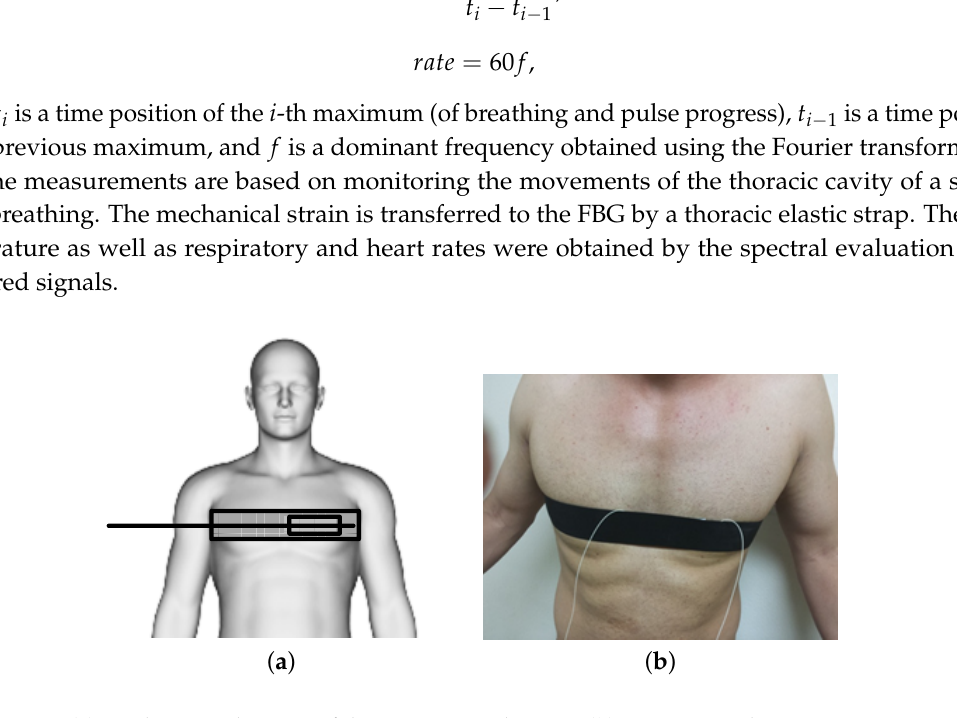
Figure 7. ( a ) A schematic diagram of the experimental set up. ( b ) Experimental set up to acquire vital sign data from a human subject using the novel probe embedded in a thoracic elastic